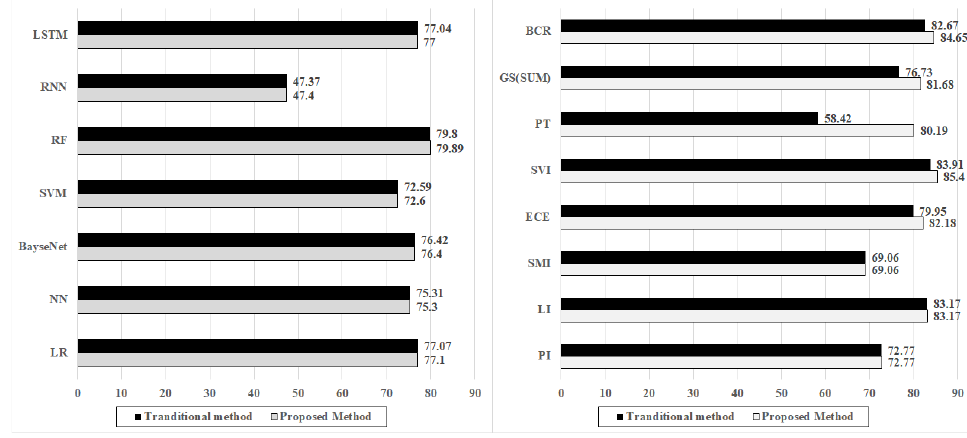
Figure 8. Comparison of the proposed and traditional methods ( left : learning algorithm; right : learning model).